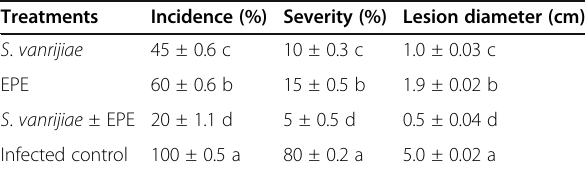
Table 2 Effect of S . vanrijiae and ethanolic extract of propolis (EPE) alone and in combination on inhibiting Penicillium digitatum on lemon fruits 7 days post-incubated at 25 °C Treatments